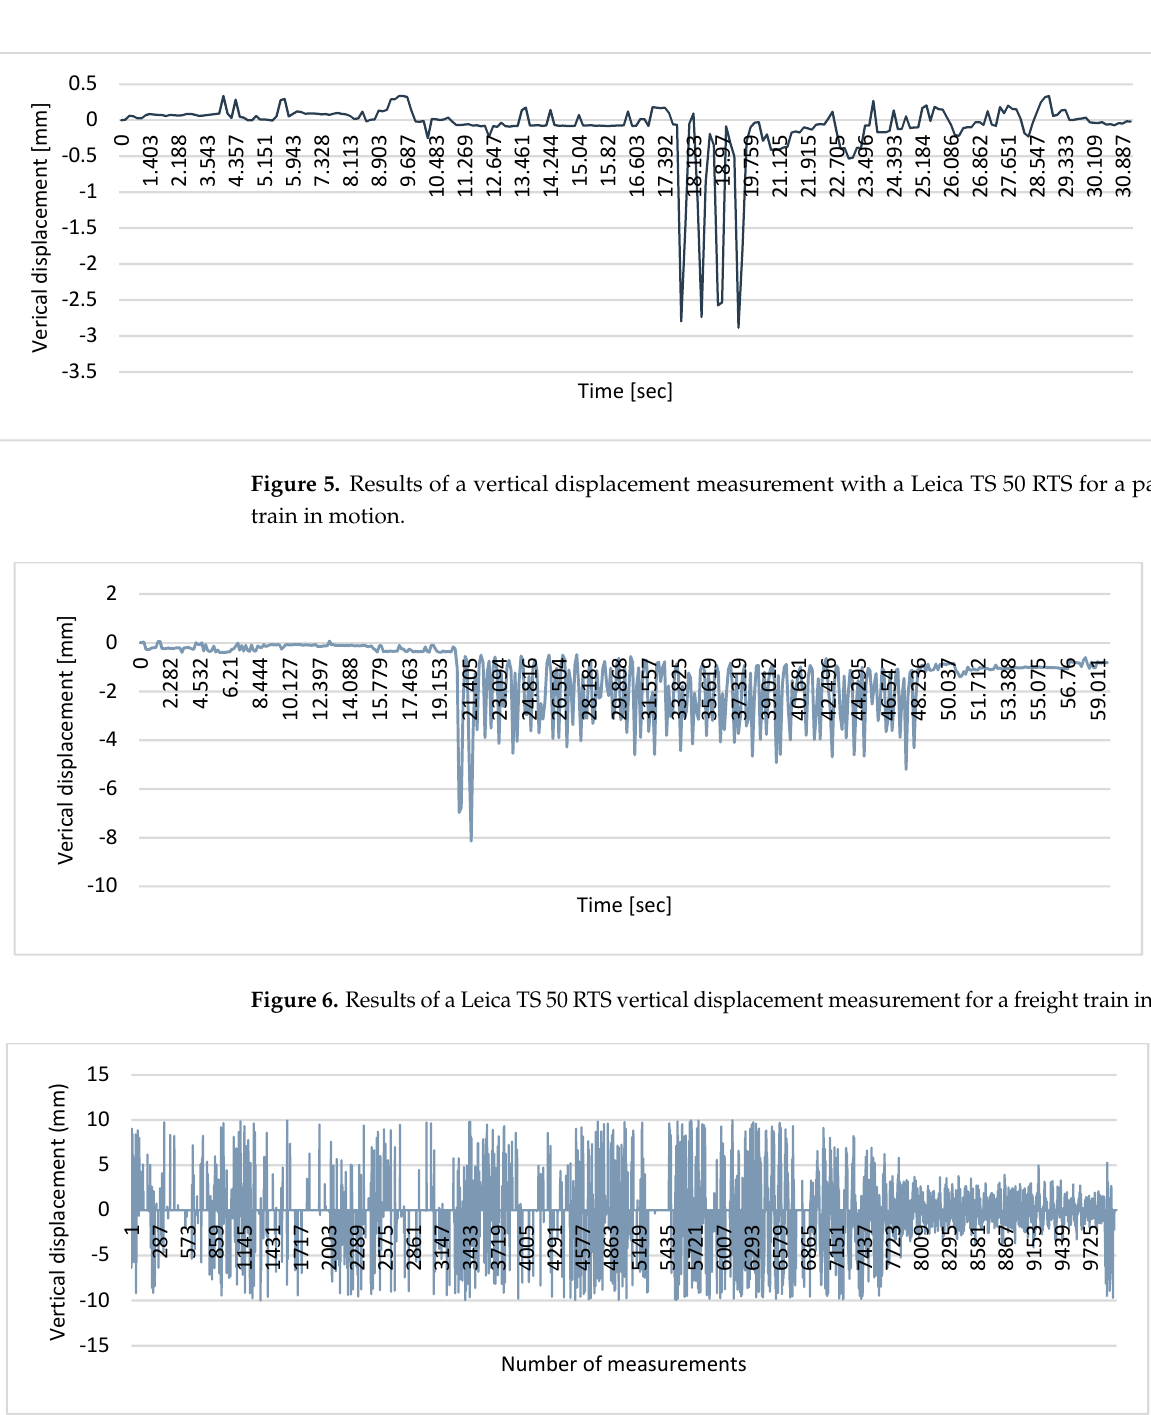
Figure 4. Results of vibration velocity measurements with the Minimate Plus seismograph for a freight train in motion, where PPV—vertical is the vertical component of the vibration velocity and the number of vibration measurements is the number of measurements recorded over a period of 31.75 s.